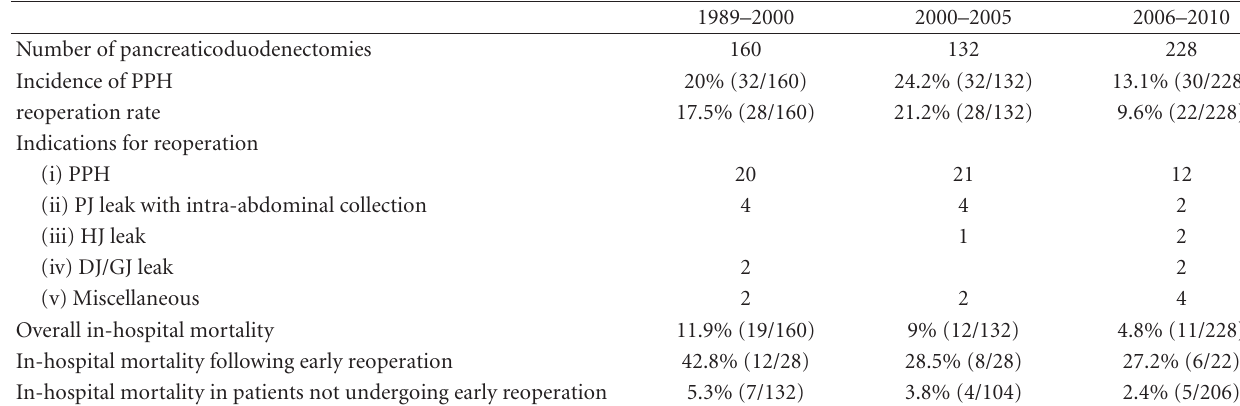
Figure 1: Indications of early reoperations and surgeries performed. Table 1: Changes over